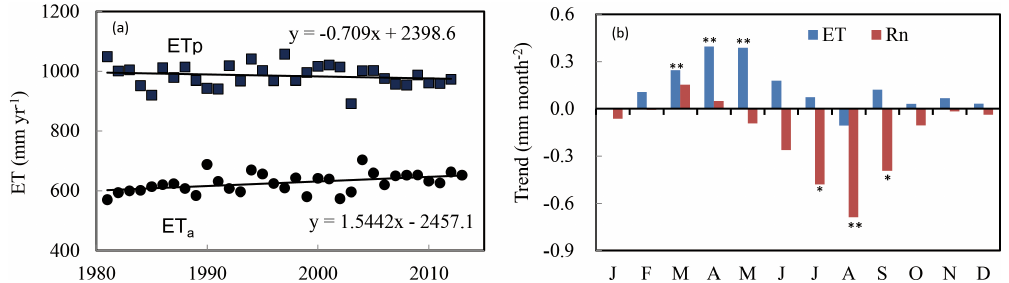
Figure 9. Inter-annual trends of potential and actual annual ET (a) and trends of monthly ET and net radiation ( R n ) (b) from 1981 to 2013 (significance levels: ∗ is p <0.05; ∗∗ is p <0.01).